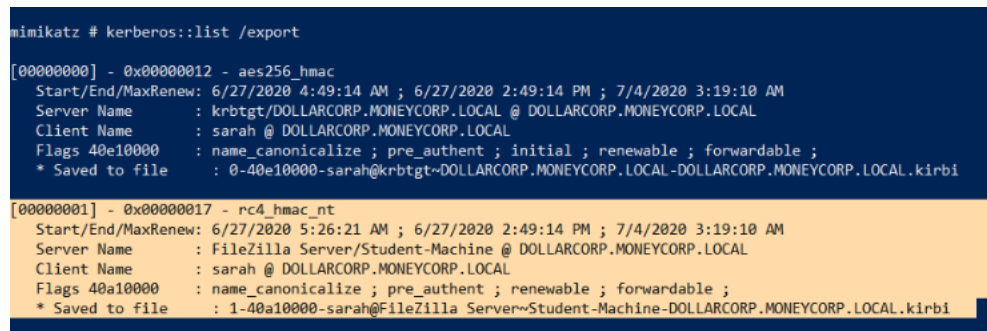
Figure 14. Service ticket issued successfully.